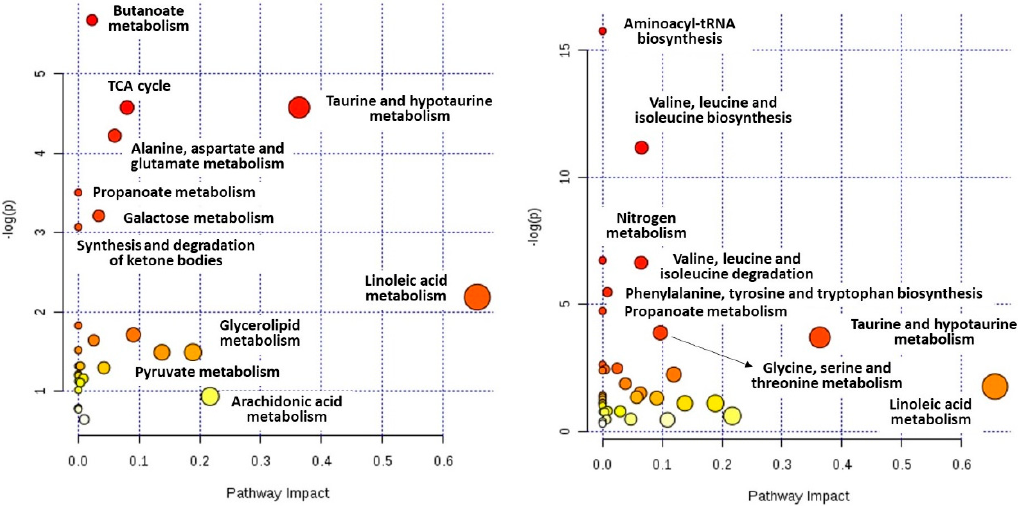
Figure 4. Summary of Pathway Analysis for group with quicker ( left ) and slower ( right ) diabetes remission.